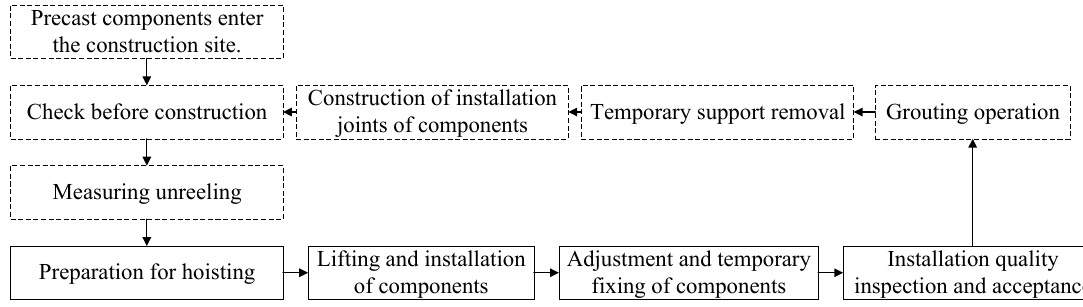
Figure 1. Specific construction procedures for hoisting of prefabricated components.